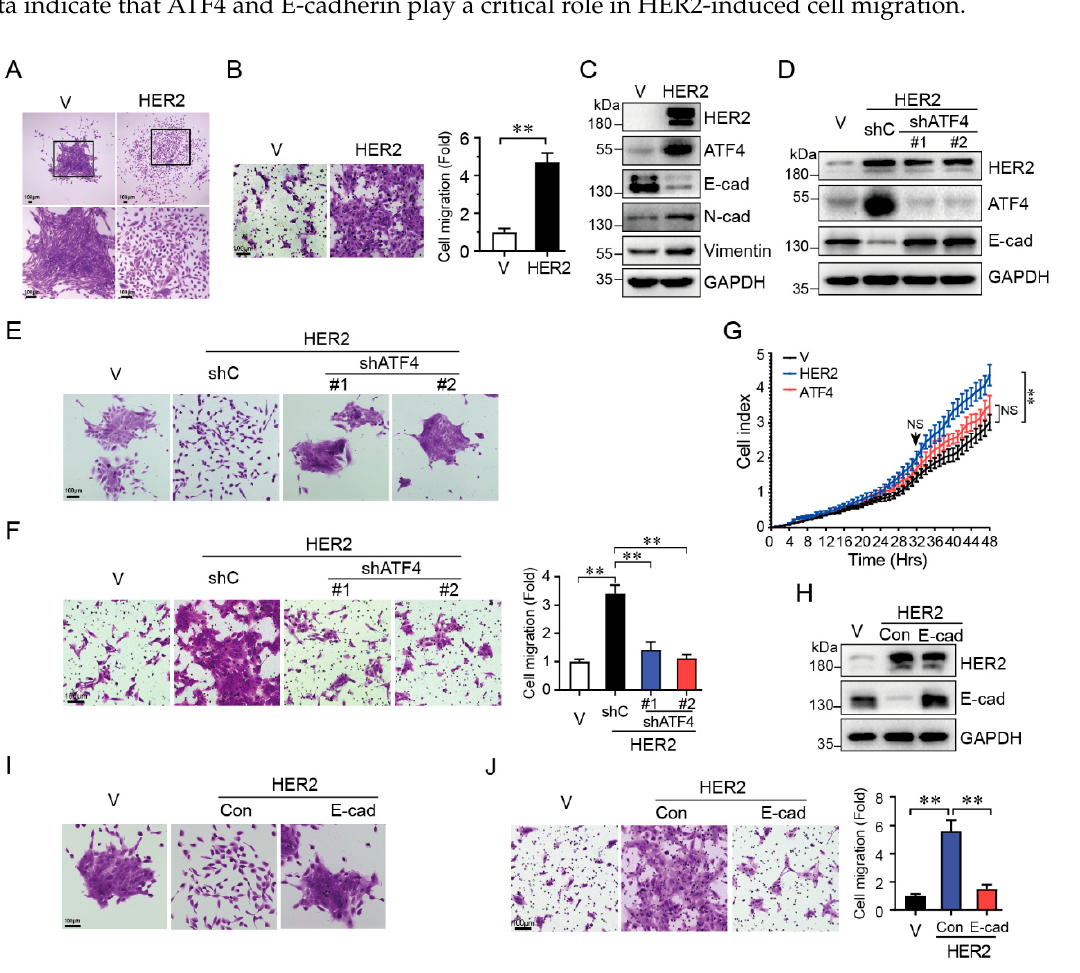
Figure 1. HER2 induces scattered cell growth and cell migration through upregulation of ATF4 and downregulation of E-cadherin expression. MCF10A cells stably expressing HER2 ( A – C ) were infected with a recombinant lentivirus expressing specific shRNA targeting to ATF4 ( D – F ) or a recombinant lentivirus expressing E-cadherin ( H–J ). Cells were then subjected to cell morphology observations ( A , E , I ), transwell assays ( B , F , J ), and Western blot analyses ( C , D , H ). MCF10A cells stably expressing HER2 or ATF4 were subjected to cell proliferation assays by Real-Time Cell Analyzer ( G ). Results are representative of three independent experiments. Data were presented as means ± SD; scale bars: 100 µ m; NS: Not significant; **: p < 0.01.